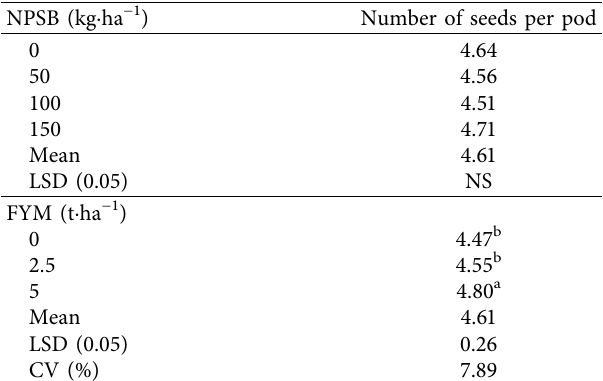
Table 6: Number of seeds per pod as afected by NPSB and FYM